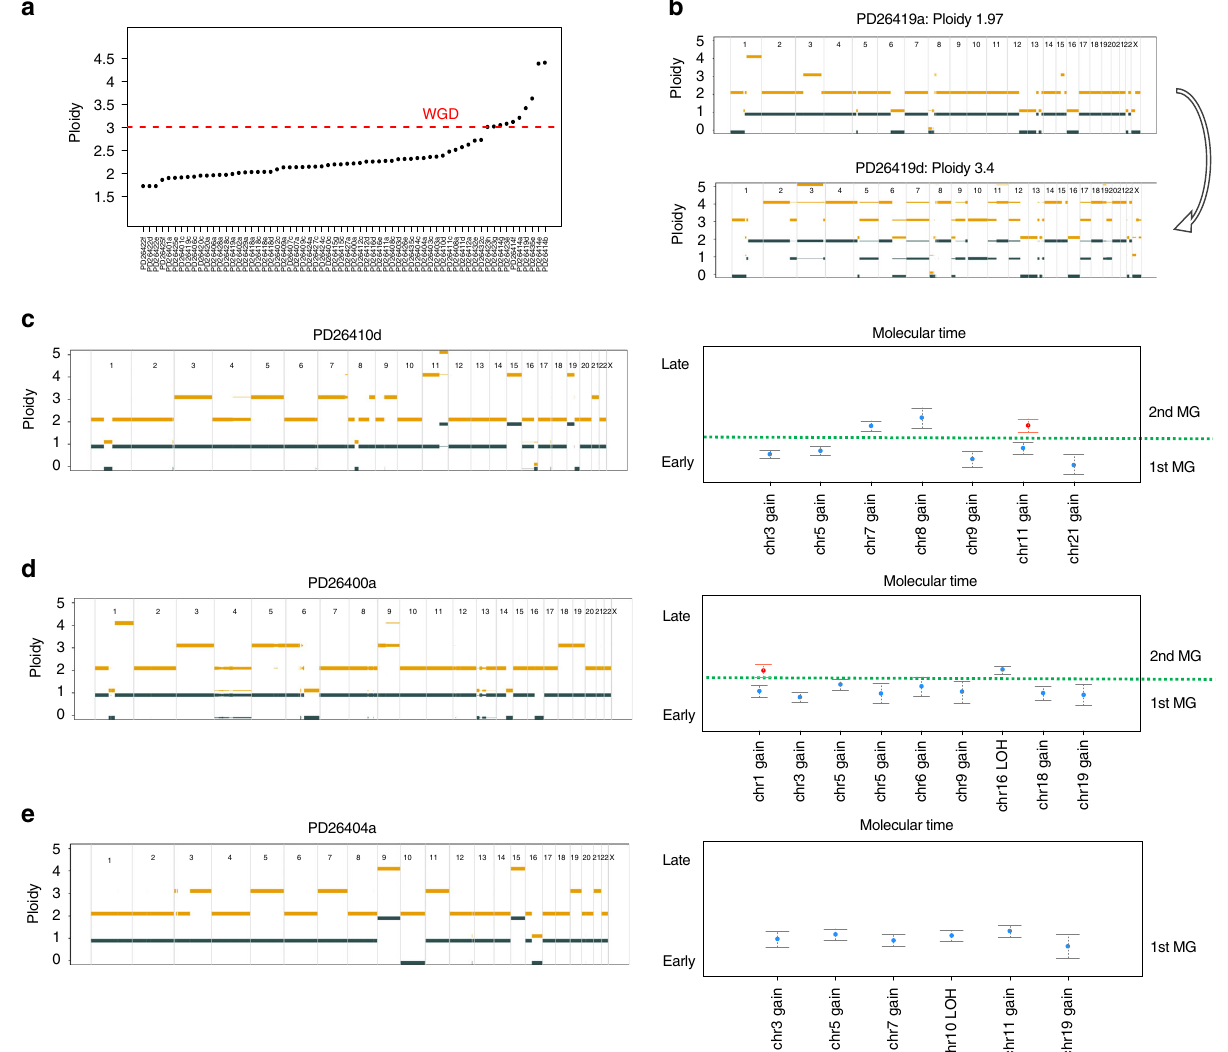
Fig. 3 Timing the clonal number changes in MM. a Summary of the sample ’ s ploidy for the entire series. Samples with ploidy > 3 (above the dashed red line) were considered as whole-genome duplication (WGD). b The copy-number pro fi le of a MM patient (PD26419) that experienced a WGD at relapse: gold line = total copy number, gray = copy number of the minor allele. The presence of more than 1 cytogenetic segment is compatible with the existence of a subclonal CNA whose CCF is proportional to the segment thickness. c – e Left, standard copy number pro fi le of 3 hyperdiploid MMs. Right, the molecular time (blue dots) estimated for each clonal gain and copy-neutral loss of heterozygosity ( “ Methods ” ). Red dots represent the molecular time of a second extra gain occurred on a previous one. Dashed green lines separate multi gain events occurring at different time